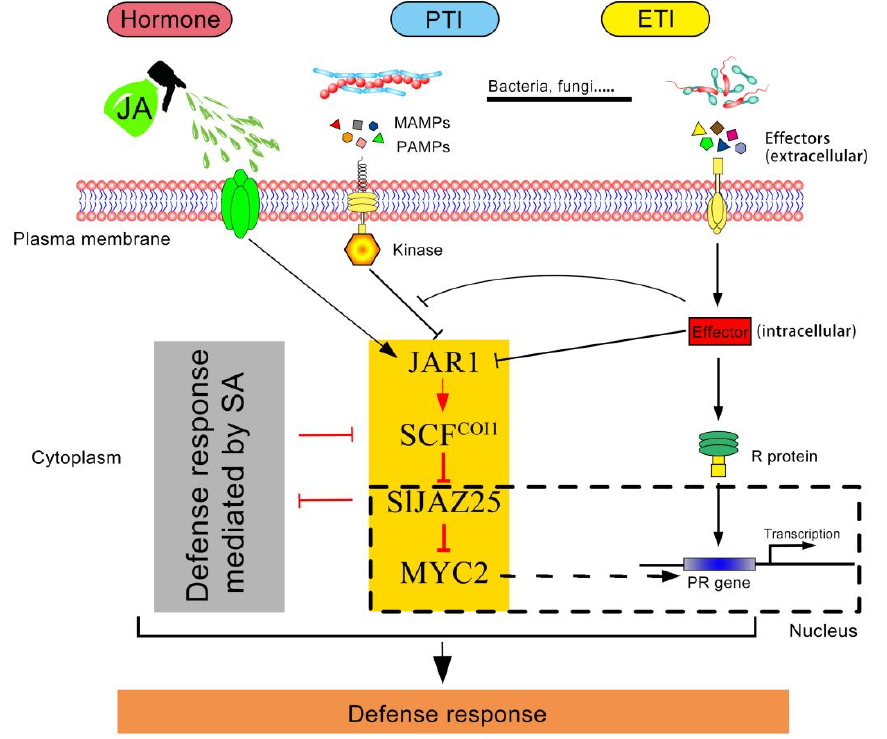
Figure 13. Hypothetical pattern of the immune response involving the participation of SlJAZ25 in tomato.